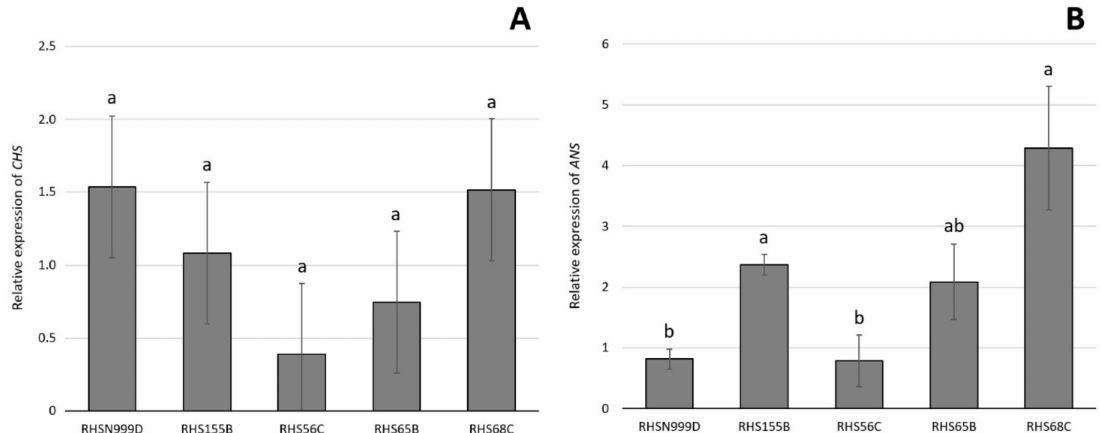
Figure 3. Relative expression of CHS ( A ) and ANS ( B ) evaluated by real time qPCR in tepals of 5 Alstroemeria pallida accessions ( ± SE, n = 12). Results are shown as expression relative to the housekeeping gene 18S rRNA . Different letters indicate significant differences using ANOVA followed by an LSD test ( p ≤